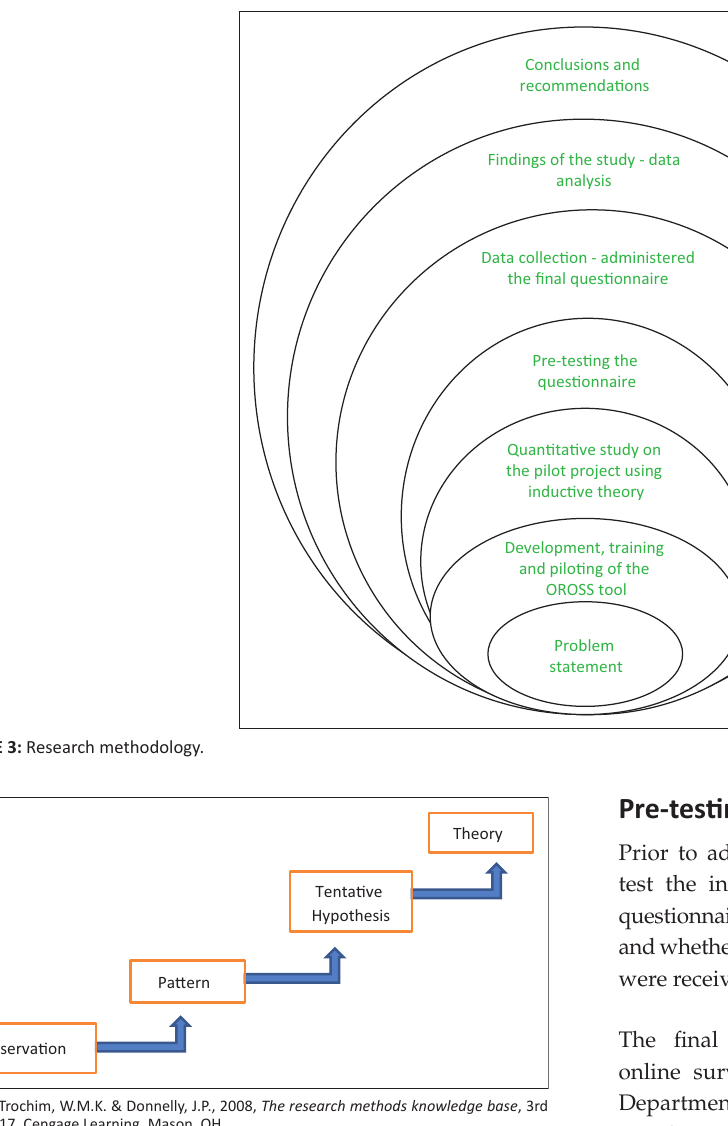
FIGURE 4: A schematic representation of inductive